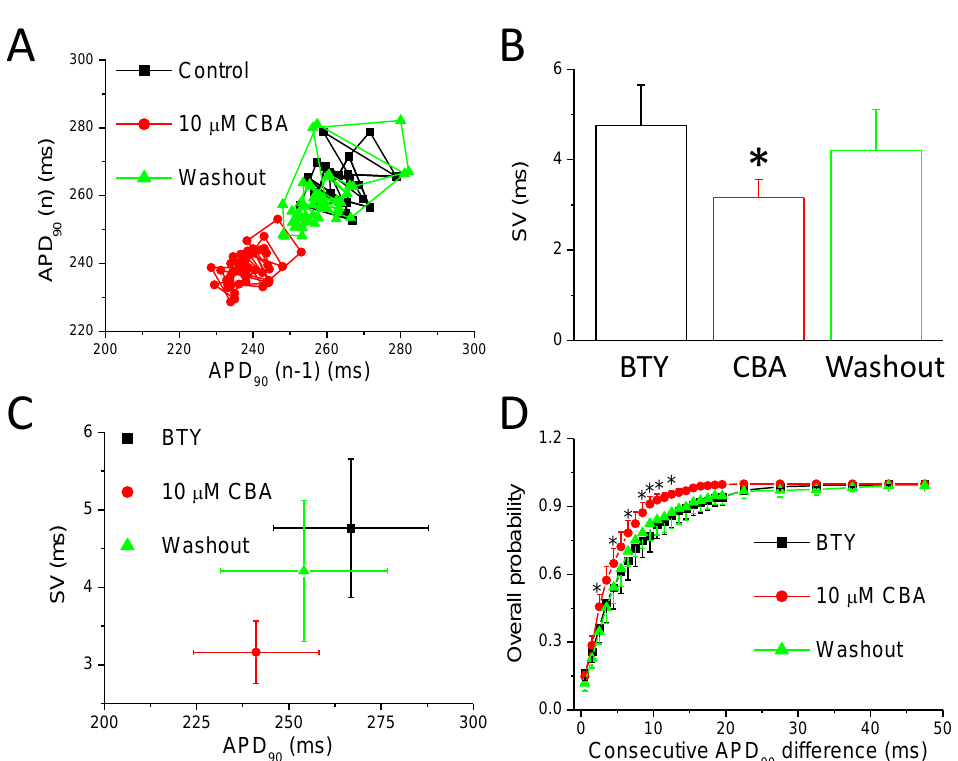
Figure 4. Short-term variability of ventricular repolarization. ( A ) Poincar é diagram of a representative experiment showing consecutive APD 90 values in control conditions (black squares), in the presence of CBA (10 µ M, red circles) and after washout of CBA (green triangles). ( B ) Average ± SEM values of short-term variability of ventricular repolarization (SV) obtained in eight cells isolated from six animals. ( C ) Average ± SEM values of SV as a function of average ± SEM values of APD 90 values in control conditions (black), in the presence of CBA (10 µM, red), and after washout of CBA (green). ( D ) Overall probability of consecutive APD 90 differences generated from eight measurements from six animals in control (black), CBA (red), and after washout (green) conditions. Asterisks show statistically significant differences compared to BTY.